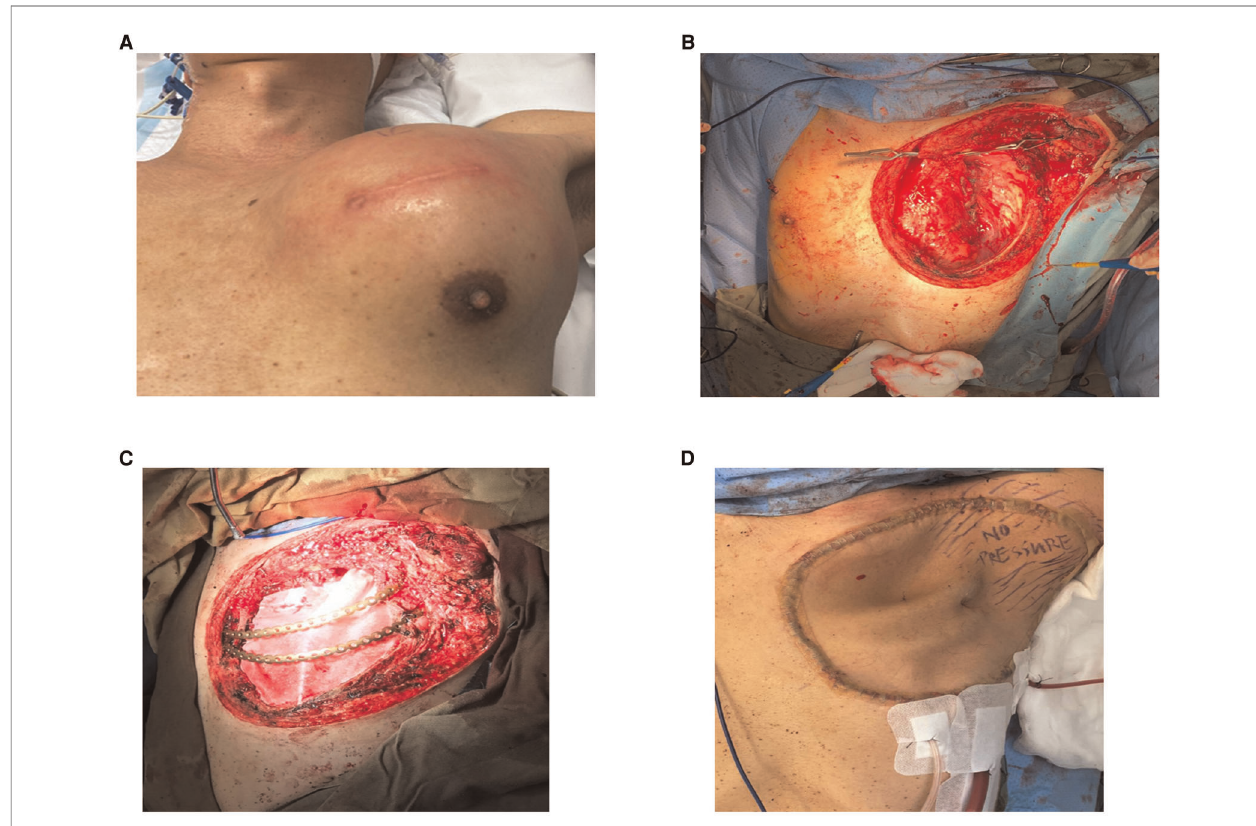
FIGURE 1 | ( A ) Large left anterior chest wall poorly differentiated carcinoma involving the sternum, second to sixth ribs, and the left upper lobe of the lung. ( B ) After resection of tumor with the chest wall, hemisternectomy, left upper lobectomy. ( C ) Reconstructed with titanium ribs. ( D ) Following coverage with the anterior lateral thigh fl ap.